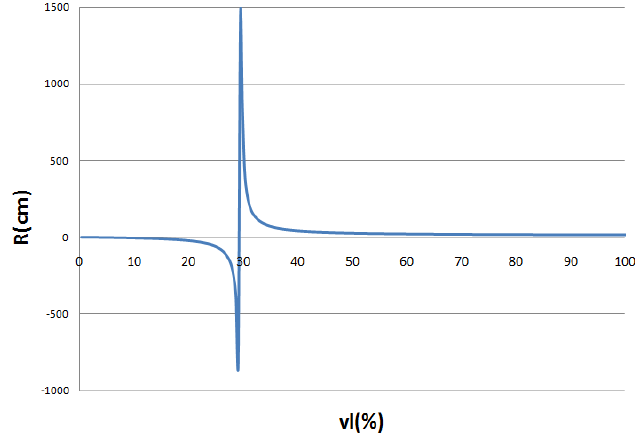
Fig.6. Graph of obtained function (vl- velocity of right wheel in